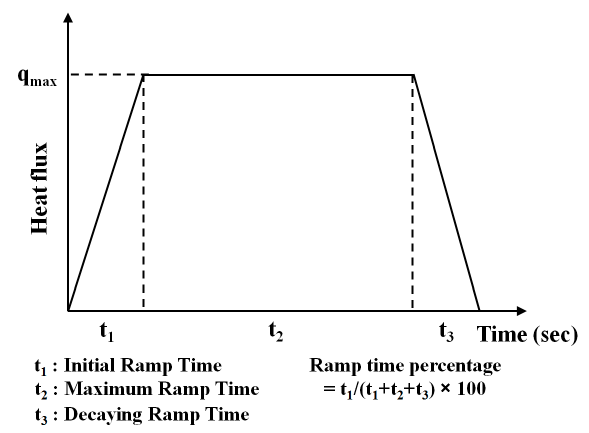
Figure 7. Temperature-dependent mechanical and thermal properties.